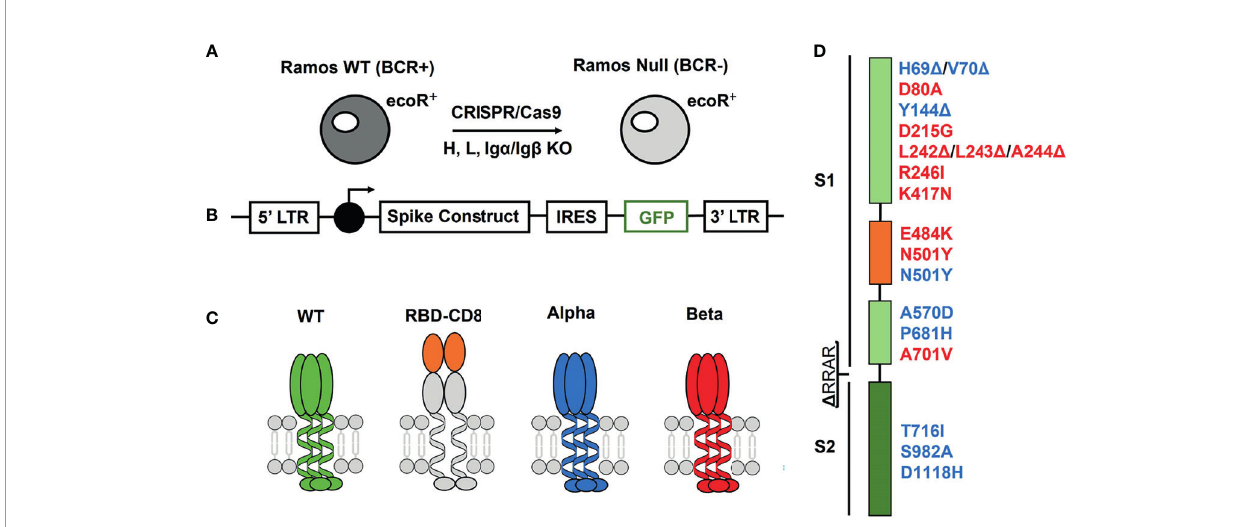
FIGURE 1 | Expression system for the generation of Ramos-null B cells carrying on their surface WT or variant spike proteins of SARS-CoV-2. (A) Generation of the Ramos-null cells lacking functional genes for the four components (heavy chain, light chain, Ig a , Ig b ) of the IgM-BCR by the CRISPR/Cas9 technique. These cells also carry the ecoR receptor for ef fi cient retroviral transfection. (B) Retroviral vector used for the linked expression of the spike protein and GFP using an internal ribosome entry site (IRES) sequence in front of the GFP cDNA. (C) Schematic drawing of the expressed S proteins with the WT (green), the receptor binding domain (RBD) (orange) attached to the murine CD8 protein (grey), the alpha variant B.1.1.7 (blue) and the beta variant B.1.3.5.1 (red). (D) Location of the amino acid exchange or deletion mutations in the S1 and S2 domain of the S protein. Alterations in the S protein of the alpha variant are indicated in blue and those of the beta variant in